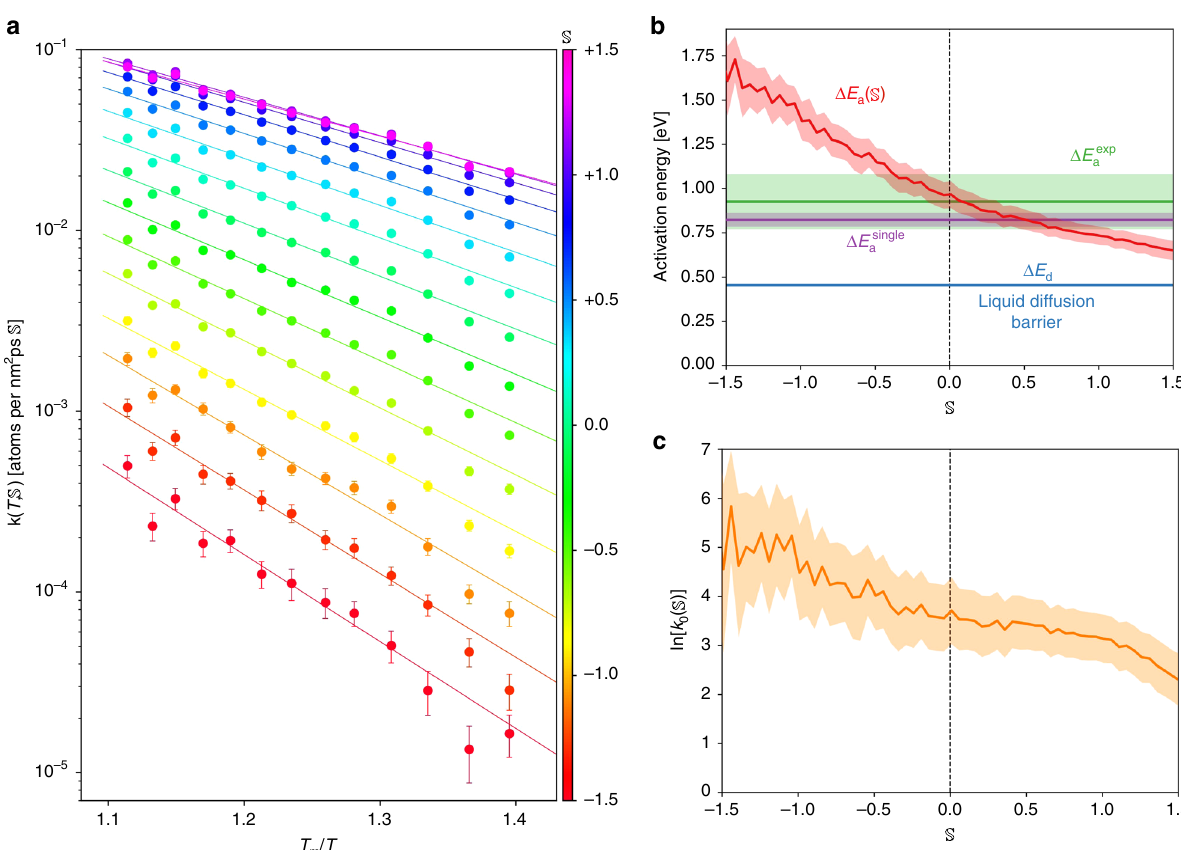
Fig. 5 Parameters of the local-structure dependent crystal growth model. a Arrhenius plot of the crystallization kinetic factor for different local structures in silicon, as encoded by softness ( S ). The Arrhenius dependence on temperature suggests that each value of S can be interpreted as a thermally activated and independent channel for crystallization with a well-de fi ned energy scale. Notice that the glass transition temperature, T m / T g ≈ 1.68 65 , is beyond the temperature range of the fi gure. b Dependence of the activation energy barrier for solidi fi cation on the local structure. The extent to which the liquid properties are affected by interface-induced ordering seems to vary greatly, from a negligible change ( Δ E a ≈ Δ E d ) to an impressive variation of over 1eV. The experimental results ( Δ E exp ) were obtained by Stolk et al. 9 and assume a single activation energy, i.e. Eq. (1) with Δ E a as a free parameter for fi tting. For a the purpose of comparison we computed the equivalent quantity in our simulations: Δ E single , which is shown to agree with the experimental results within a the accuracy of the error bars. c Arrhenius prefactor dependence on S . The decrease of three orders of magnitude with S implies that there are less rearrangement pathways leading liquid atoms to the activated crystallizing state as S increases. All error bars reported are the standard deviation of their respective parameters, except for Δ E exp where we report the value quoted by Stolk et al. 9 a